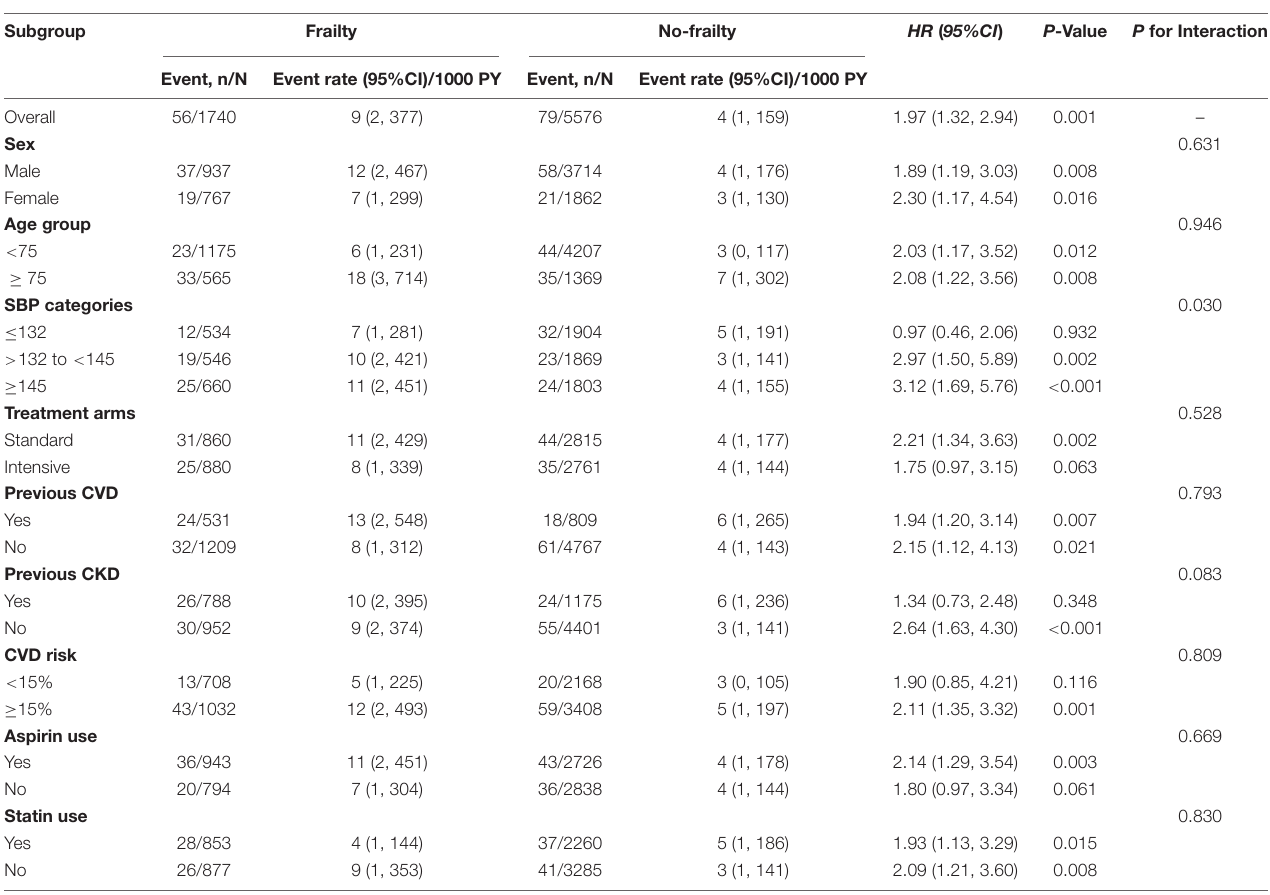
TABLE 3 | Subgroup analysis of the risk of new-onset AF between frailty and